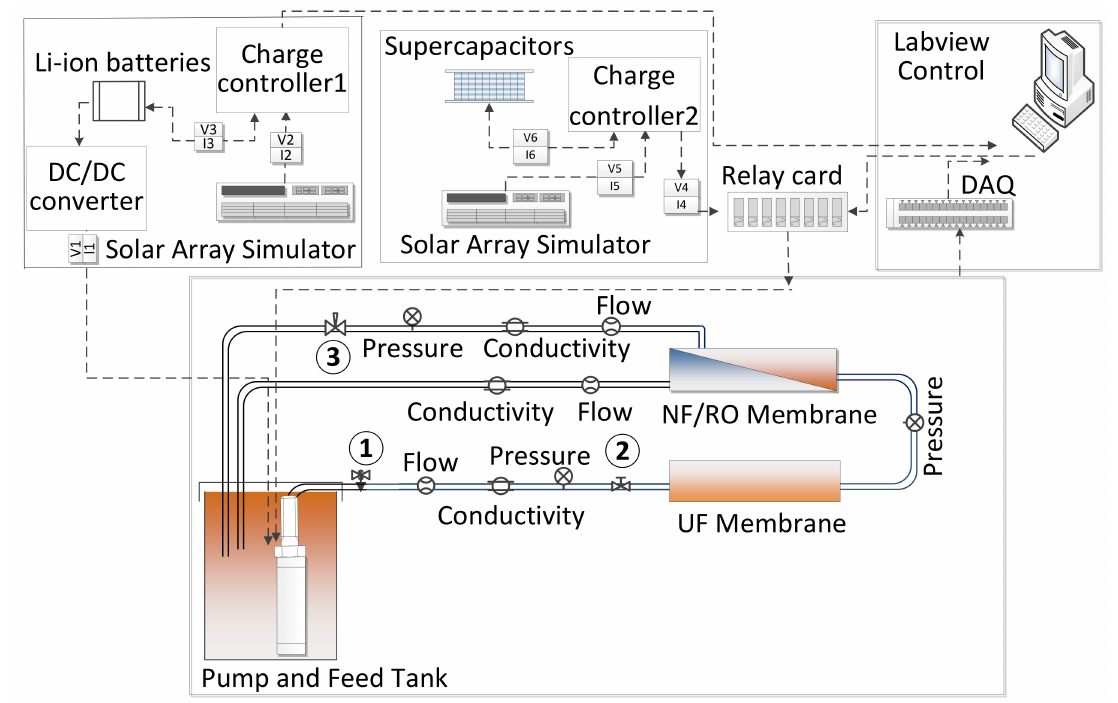
Figure 1. Schematic of the photovoltaic (PV)-membrane system equipped with a lithium-ion (Li-ion) battery pack or supercapacitors (SCs) for energy storage. Note the directly coupled system is configured by connecting the solar array simulator (SAS) to the pump, and the change between the battery and SC configurations is manually switched. All sensors for measuring flow, pressure, conductivity, voltage (V) and current (I) are connected to a data acquisition card (DAQ) and computer. The solid lines represent the hydraulic connections, while dashed lines represent the electrical connections. Note: The numbers indicate the valves within the system: 1 (cid:13) : safety valve, 2 (cid:13) : check valve and 3 (cid:13) : needle valve for creating back pressure. NF/RO: nanofiltration/reverse osmosis, UF: ultrafiltration and DC: direct